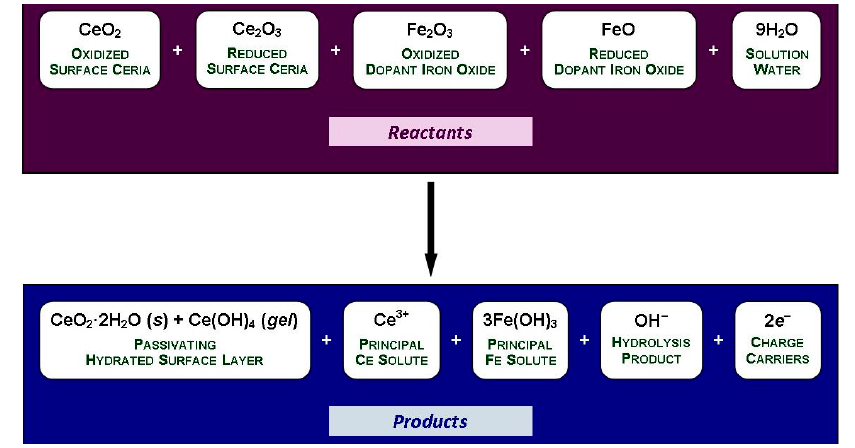
Figure 10. General equilibria for the immersion of Fe ‐ doped CeO 2 in water.